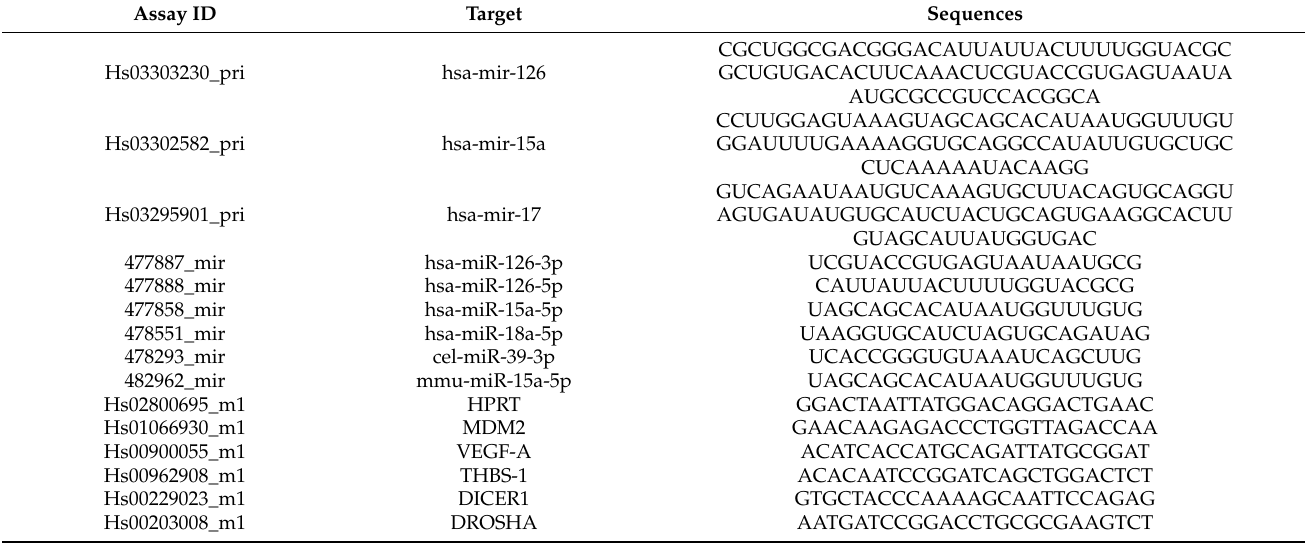
Table 1. List of Taqman probes used to measure RNA transcripts. For pri-miR and miR target name, the first three letters signify the organism: ‘hsa’ for human origin, ‘cel’ for C. elegans and ‘mmu’ for murine origin. Then, the three following letters ‘mir’ and ‘miR’ indicate sequences of pri-miR and mature miR, respectively. At the end of the target name, 3p and -5p indicate that the sequence originates from 3 (cid:48) or 5 (cid:48) arm, respectively. Assay ID Target